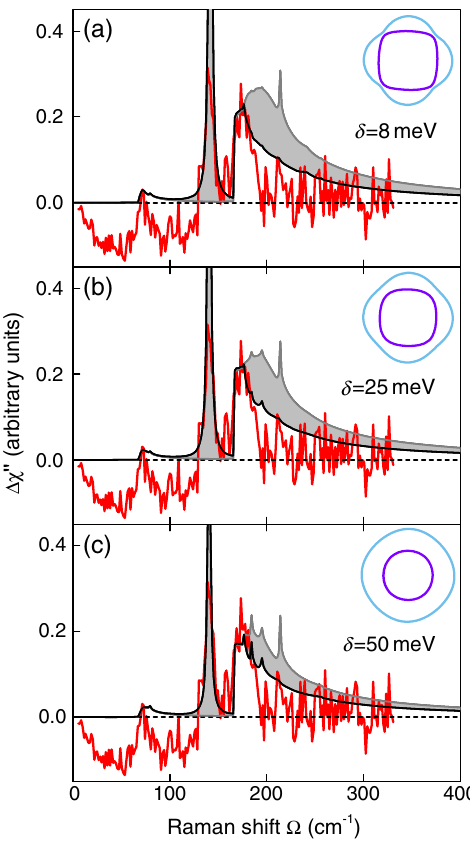
FIG. 7. Results for B 1 symmetry using different hybridization g energies δ as indicated. The insets show a cut through the two ¼ π = 2 electron bands at k z